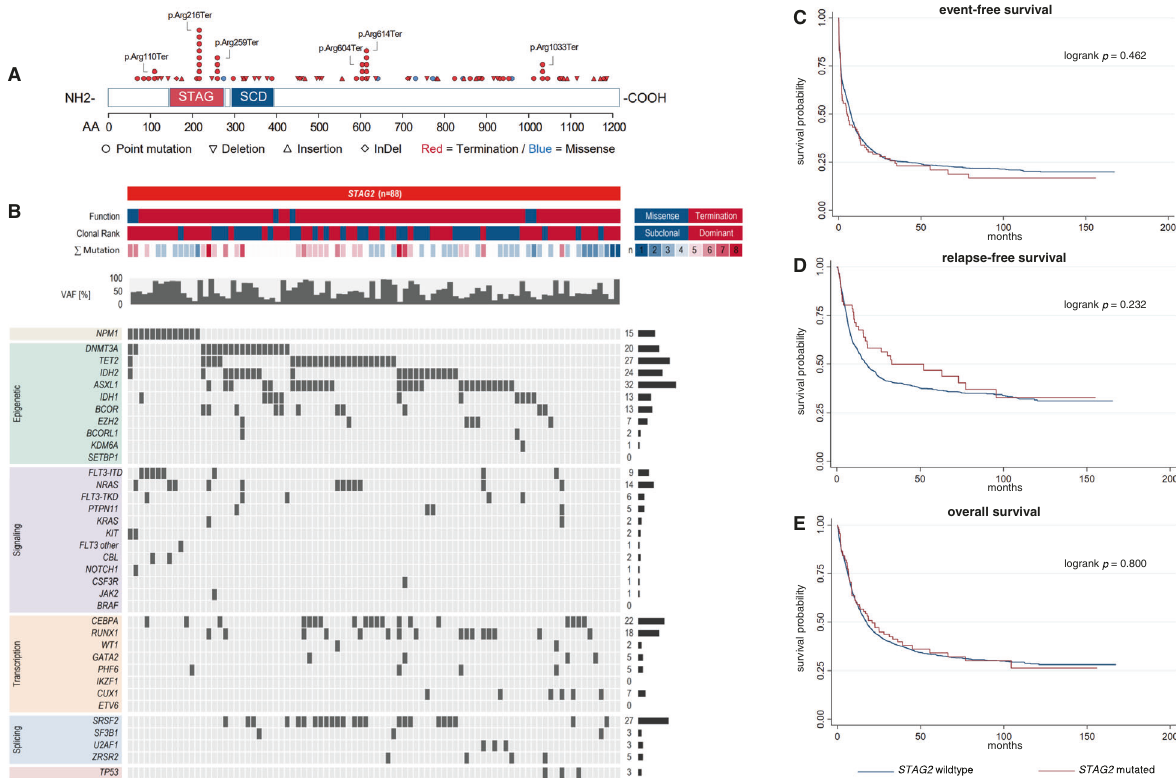
Fig. 1 Distribution, co-mutational spectrum and survival analysis for AML with mutated STAG2 . Graphic representation of the domain structure of STAG2 and positions of STAG2 mutations in 88 AML patients ( A ). Mutations of STAG2 are categorized by function (missense = blue, termination = red), clonal rank (dominant = red/subclonal = blue), number of mutations, and variant allele fraction, and associated co-mutations ( B ). For detailed information on co-mutations and results of individual signi fi cance tests, see Tab. S4. Survival analysis using the Kaplan-Meier method and log-rank test for event-free ( C ), relapse-free ( D ) and overall survival ( E ) differentiating between STAG2 -mutated and STAG2 - wildtype normal karyotypes (70.6% vs. 50.8%, p = 0.009), while complex